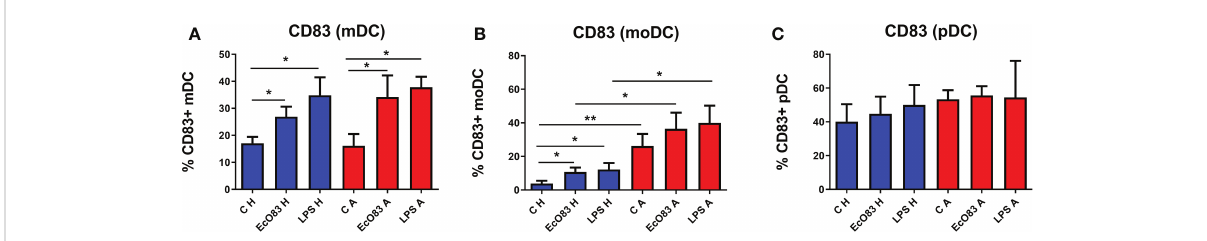
FIGURE 5 The effect of E coli O83:K24:H31 (EcO83) on the induction of the activation marker CD83 on myeloid dendritic cells (mDCs), monocyte-derived dendritic cells (moDCs), and plasmacytoid dendritic cells (pDCs) obtained from the cord blood of newborns of healthy and allergic mothers. mDCs isolated directly from cord blood cells were stimulated with EcO83, and the cell surface activation marker CD83 was inspected after 24 h (A) . The effect of EcO83 stimulation on the maturation of moDCs is presented in (B) The impact of EcO83 stimulation on the induction of CD83 on in vitro -derived pDCs is shown in (C) C H, non-stimulated DCs of newborns of healthy mothers; C A, non-stimulated DCs of newborns of allergic mothers; EcO83 H, DCs of newborns of healthy mothers stimulated with E coli O83:K24:H31; EcO83 A, DCs of newborns of allergic mothers stimulated with E coli O83:K24:H31; LPS H, DCs of newborns of healthy mothers stimulated with lipopolysaccharide; LPS A, DCs of newborns of allergic mothers stimulated with lipopolysaccharide; *p ≤ 0.05; **p ≤ 0.01.